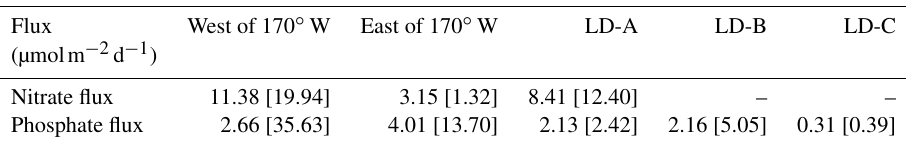
Table 4. Statistics in the western and eastern parts: mean values of the NO 3 and PO 4 turbulent diffusive fluxes in the photic layer. The standard deviation is given within the